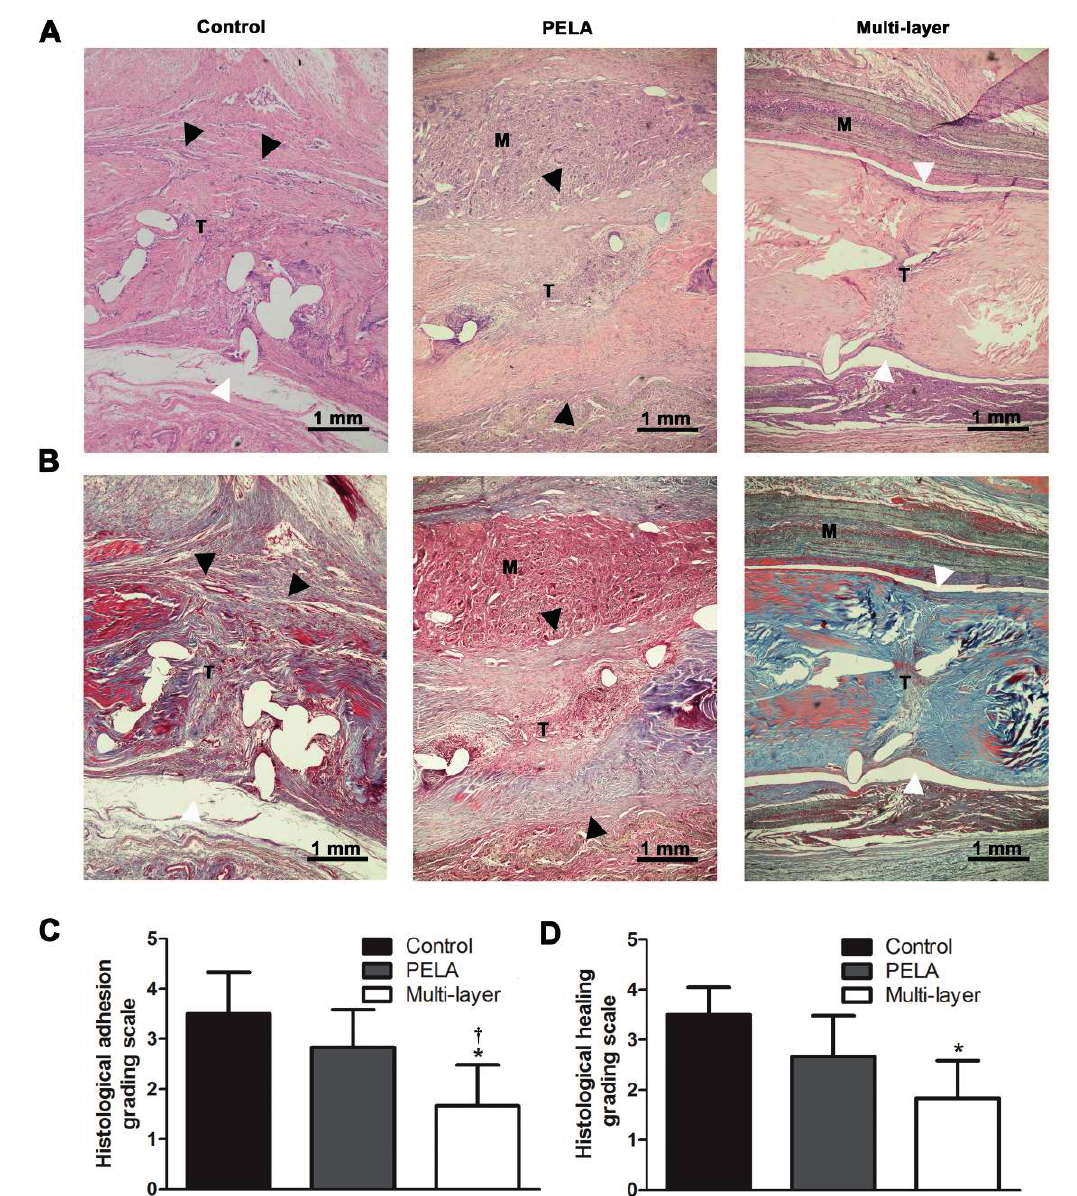
Figure 3. HE ( A ) and Masson ( B ) staining of untreated repair site, repair sites wrapped with unloaded PELA fibrous membrane and wrapped with a multi-layer fibrous membrane. White arrowheads indicate the interface without peritendinous adhesions, while black arrowheads indicate peritendinous adhesions between the membrane (M) and tendon (T) (Scale bar = 1 mm). Peritendinous adhesions and tendon repair are evaluated by determining histological adhesion grade ( C ) and histological healing grade ( D ). * p < 0.05 compared with control group; † p < 0.05 compared with PELA membrane group. Data are expressed as mean ± SEM for six